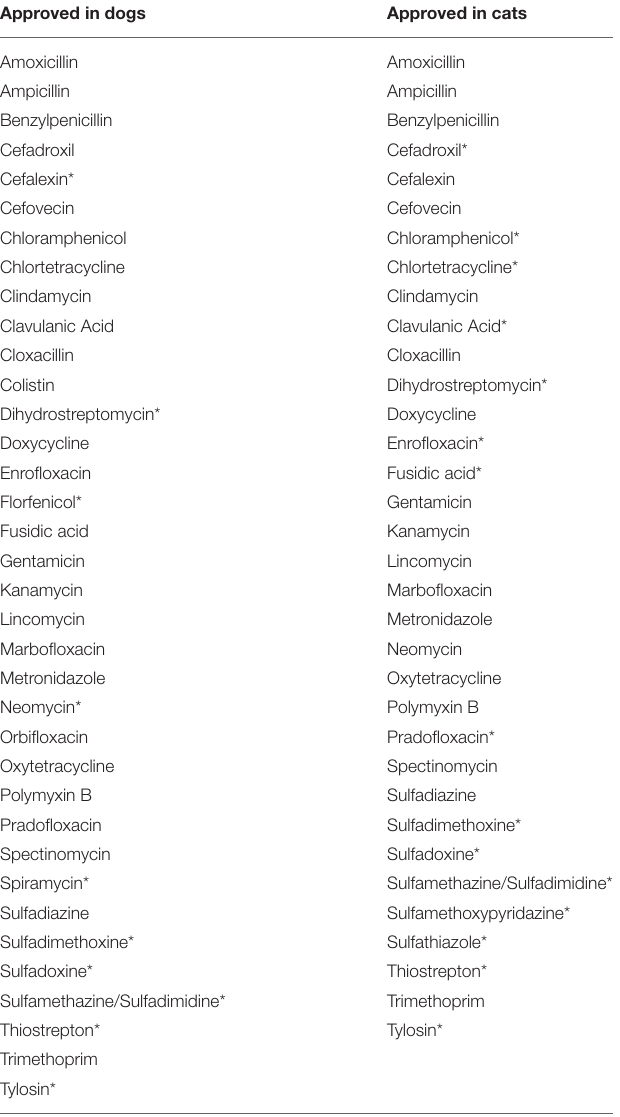
TABLE 1 | List of antimicrobial substances approved for dogs and cats in the EU. Approved in